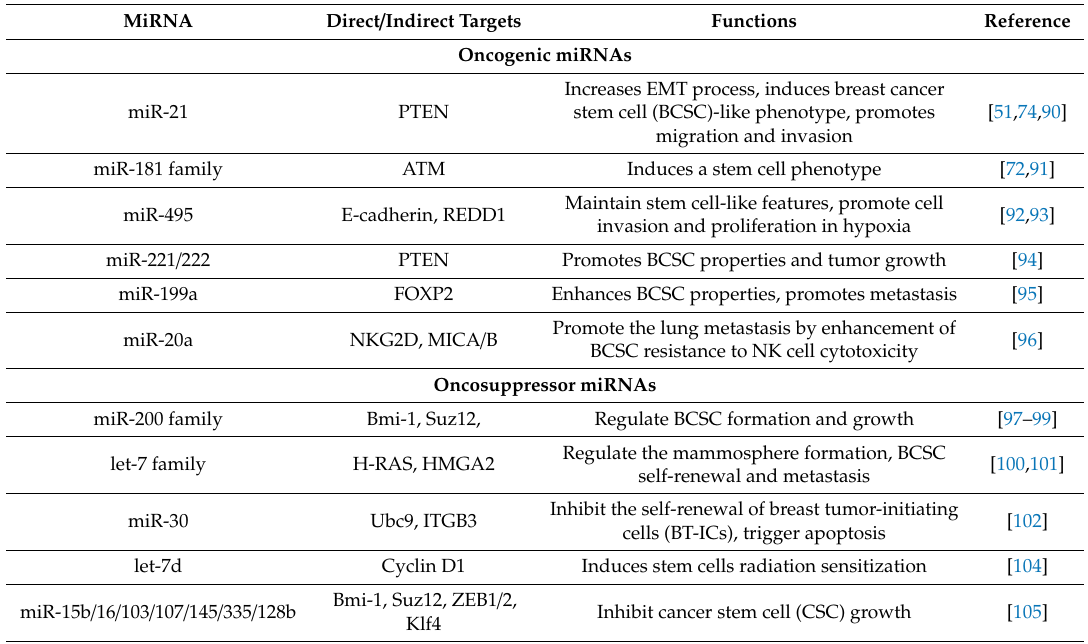
Table 4. MiRNAs associated with maintenance of stemness in